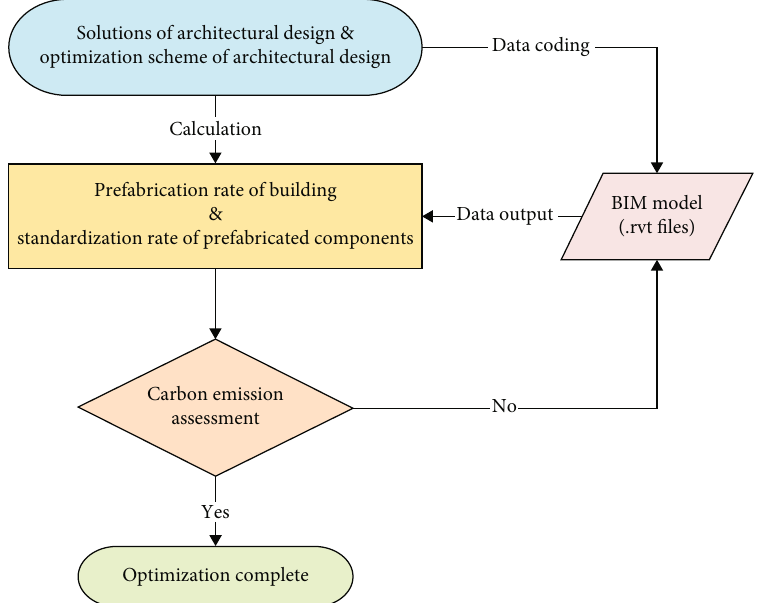
Figure 1: Design phase carbon emission evaluation